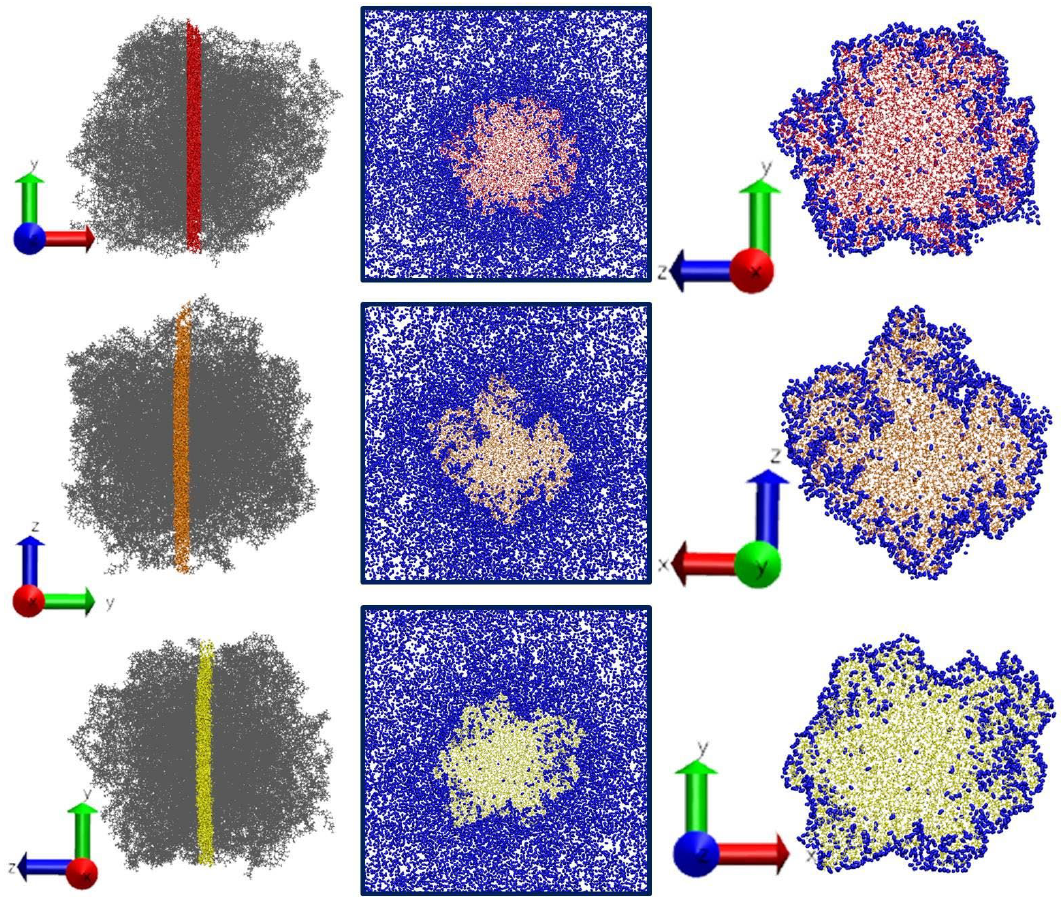
Figure 9. Instant snapshots of PMMA samples in three directions. Blue represents CO 2 molecules. The red, orange, and yellow colors in the figure represent sections of the polymer from the center of the sample in three different planes. It can be seen from the figure that some of the CO 2 molecules are not uniformly distributed in the polymer volume. The simulation results were used to further estimate the proportion of CO 2 sorbed by the PMMA polymer matrix.